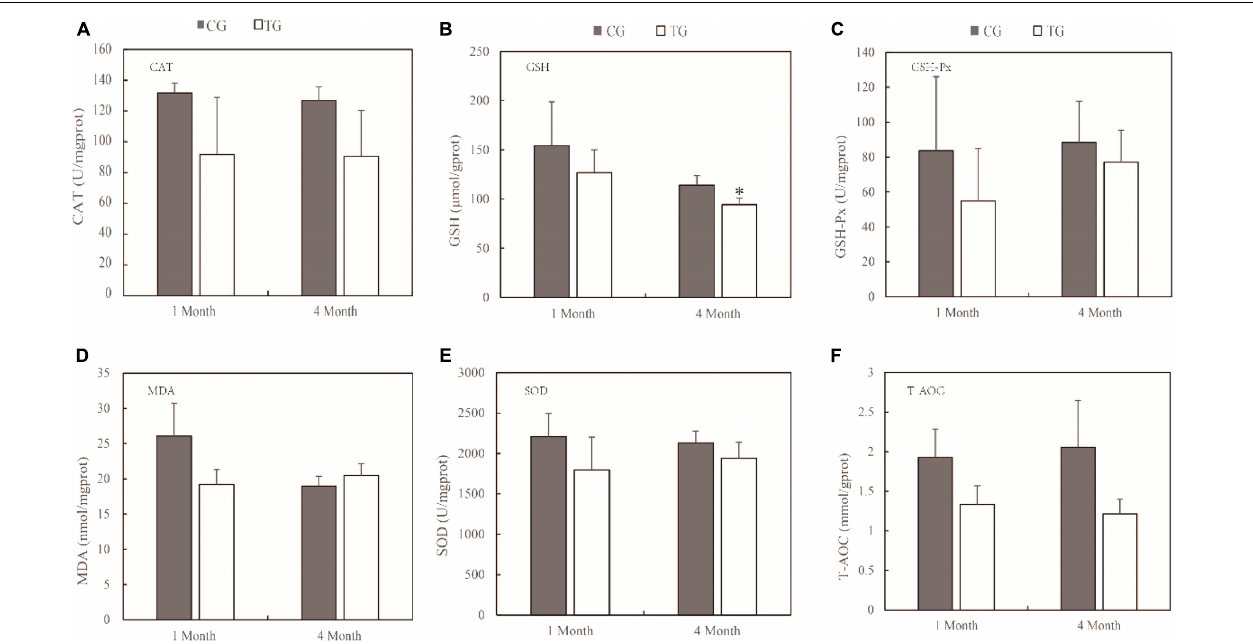
FIGURE 1 | Antioxidant responses of adult zebrafish exposure to TWTP effluents (1 and 4 months) in the gut tissue. Catalase (CAT) (A) , glutathione (GSH) (B) , Glutathione peroxidase (GSH-Px) (C) , malondialdehyde (MDA) (D) , superoxide dismutase (SOD) (E) , and total antioxidant capacity (T-AOC) (F) . Data are presented as the mean ± SD ( n = 24 fish/treatment). ∗ Stands for significant differences among treatments compared with the control using one-way analysis of variance (ANOVA) followed by Duncan’s multiple comparisons ( P < 0.05).